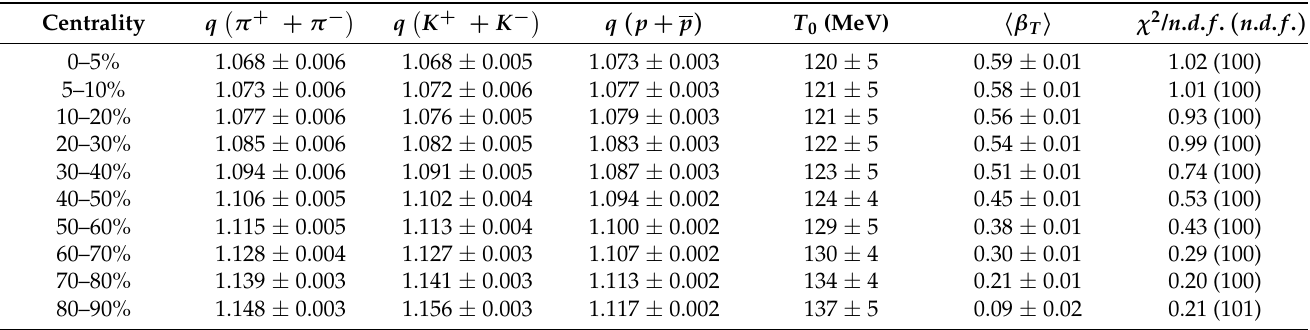
Table 3. The results obtained from combined minimum χ 2 fits with thermodynamically NON- consistent Tsallis function with transverse flow (Equation (4)) of midrapidity p T spectra of particles √ s nn = 2.76 in Pb + Pb collisions at